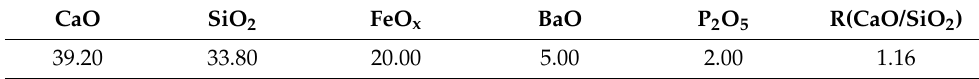
Table 4. Chemical compositions of CaO–SiO 2 –FeO–BaO–P 2 O 5 slag (wt.%).